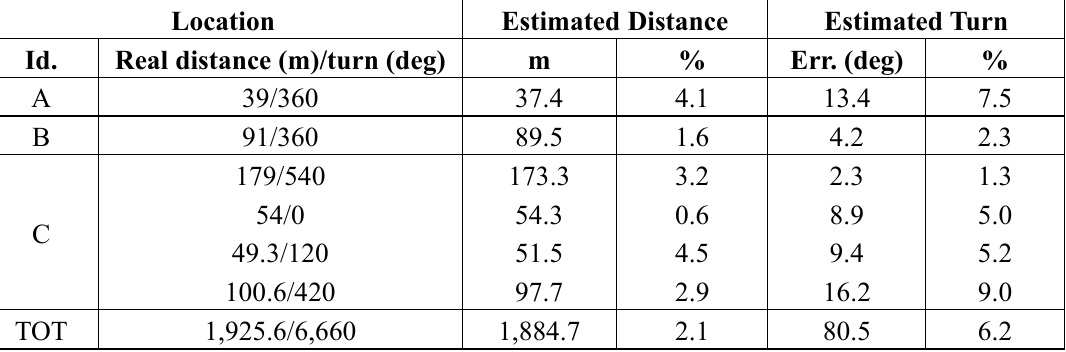
Table 1. Indoor experiment results in Locations A, B, C in Figures 2 and 3. Real distance and turn degrees were measured at each location, and compared to estimated ones at the end of the